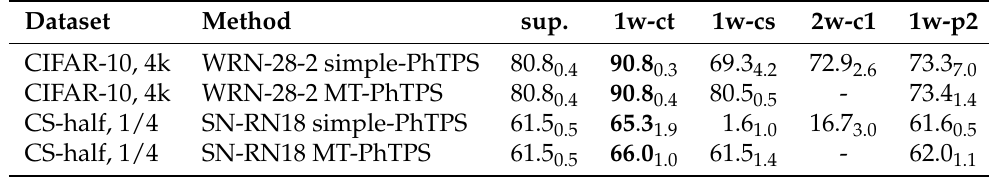
Table 5. Comparison of 4 consistency variants under PhTPS perturbations: one-way with clean teacher (1w-ct), one-way with clean student (1w-cs), two-way with one input clean (2w-c1), and one- way with both inputs perturbed (1w-p2). Algorithms are evaluated on CIFAR-10 test (accuracy/%) while training on 4000 out of 50,000 labels (CIFAR-10, 2/25) and half-resolution Cityscapes val (mIoU/%) while training on 1/4 of labels from Cityscapes train with SwiftNet-RN18 (CS-half,